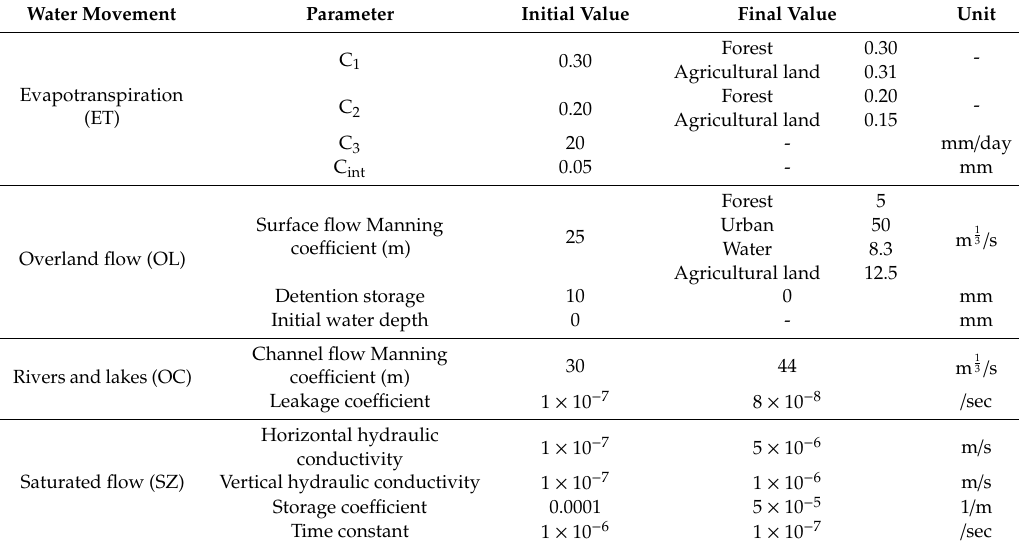
Table 3. Key parameters controlling evapotranspiration, overland flow, drainage flow, and base flow were subject to